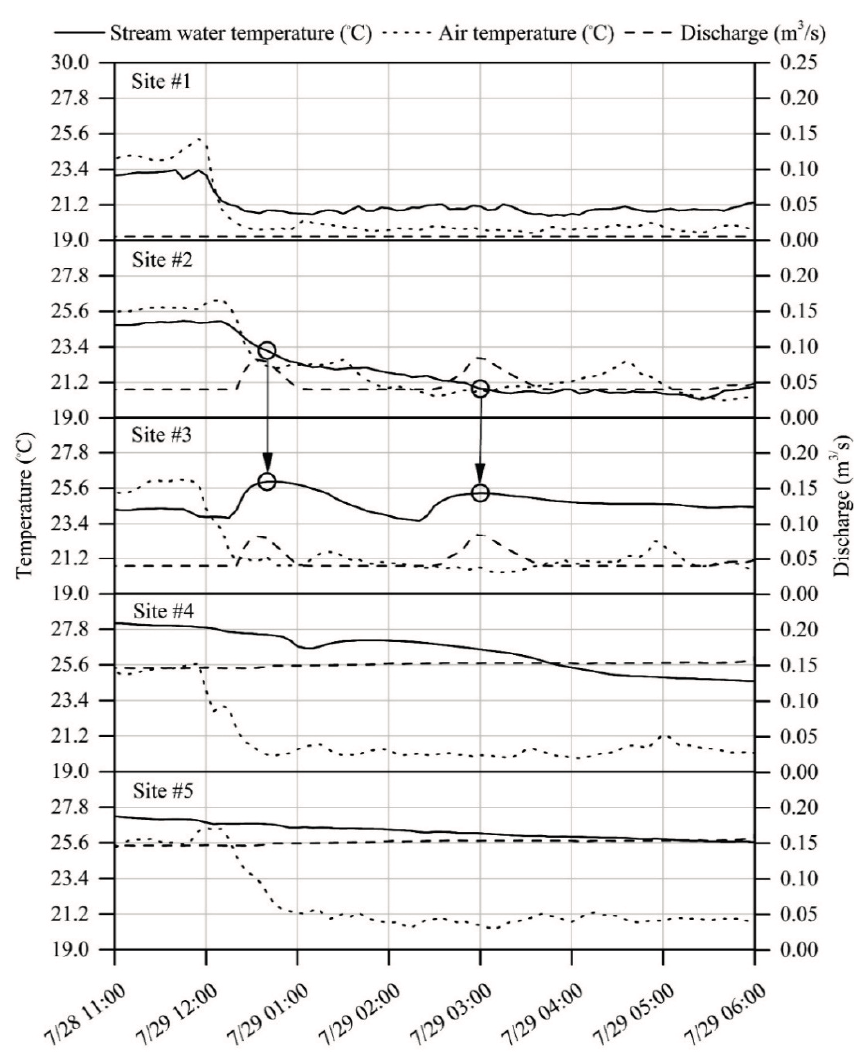
Figure 6. Two stream water temperature surges sensed at site #3 in Hinkson Creek following a summer thunderstorm during summer 2012. The black circles mark the peak T w following the increase in discharge at site #3 and the arrows track the event downstream from site #2 to site